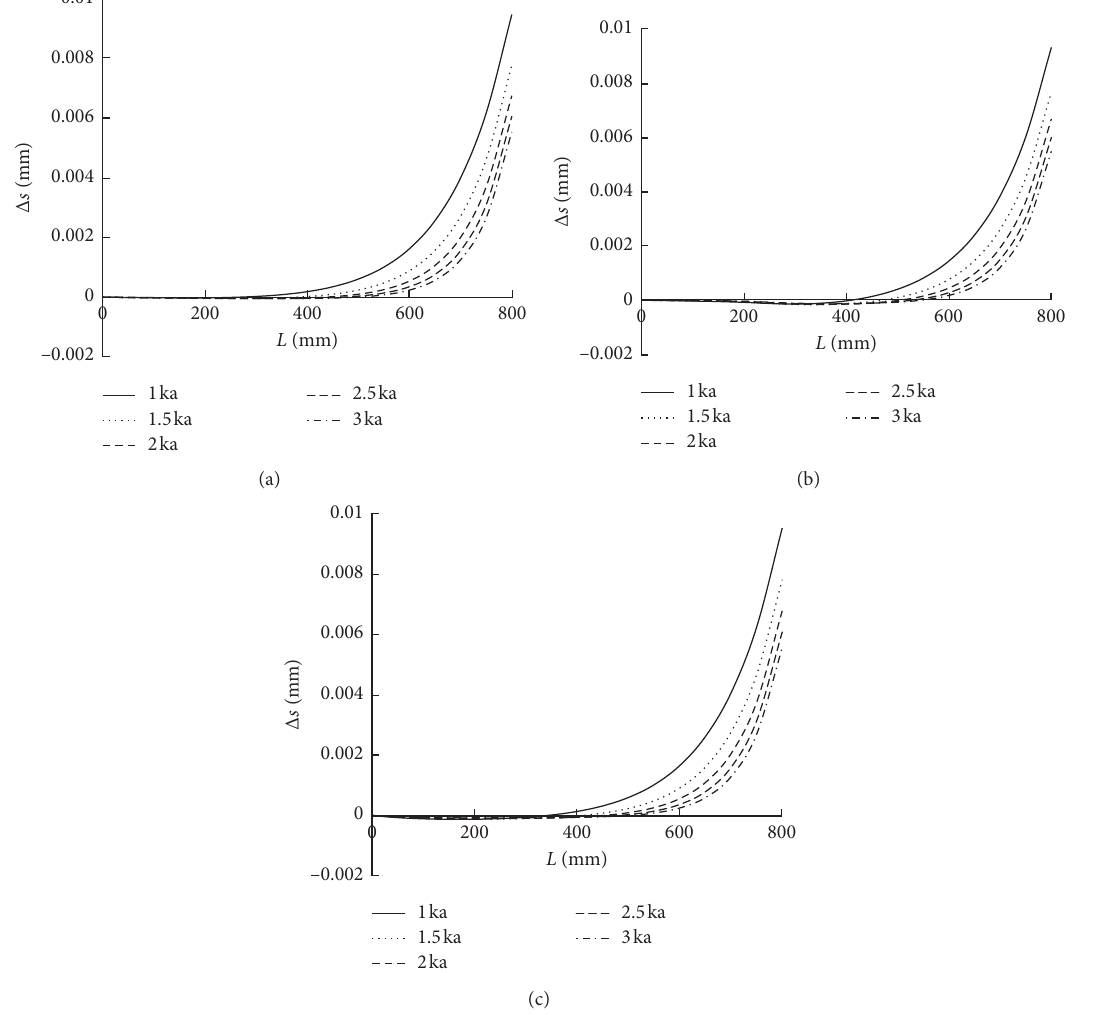
Figure 7: The effect of adhesive layer stiffness on the interface slip. (a) Uniform load. (b) Symmetrical concentrated load. (c) Midspan concentrated